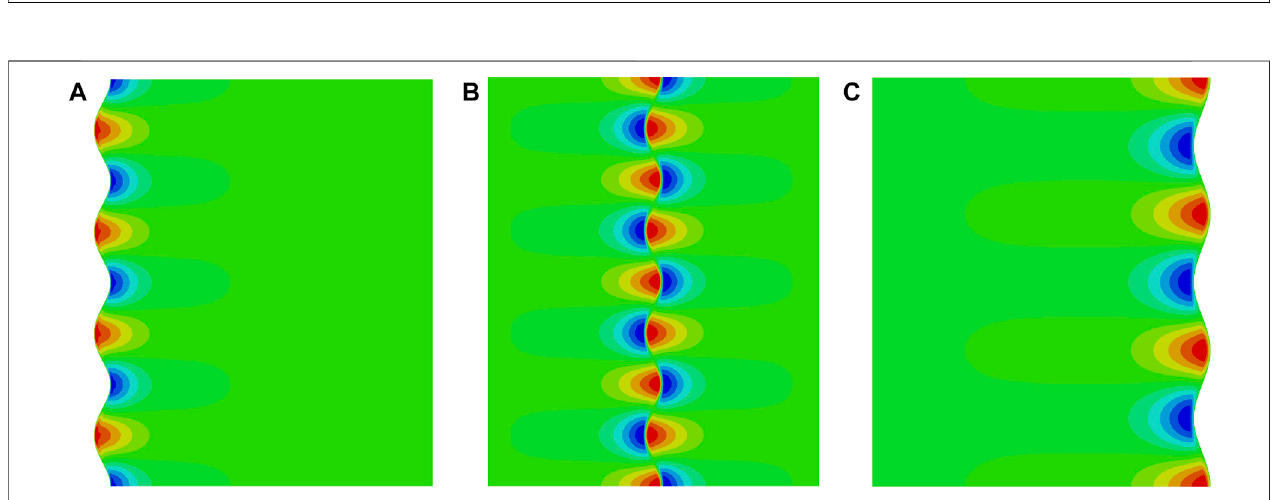
Frontiers in Mechanical Engineering |